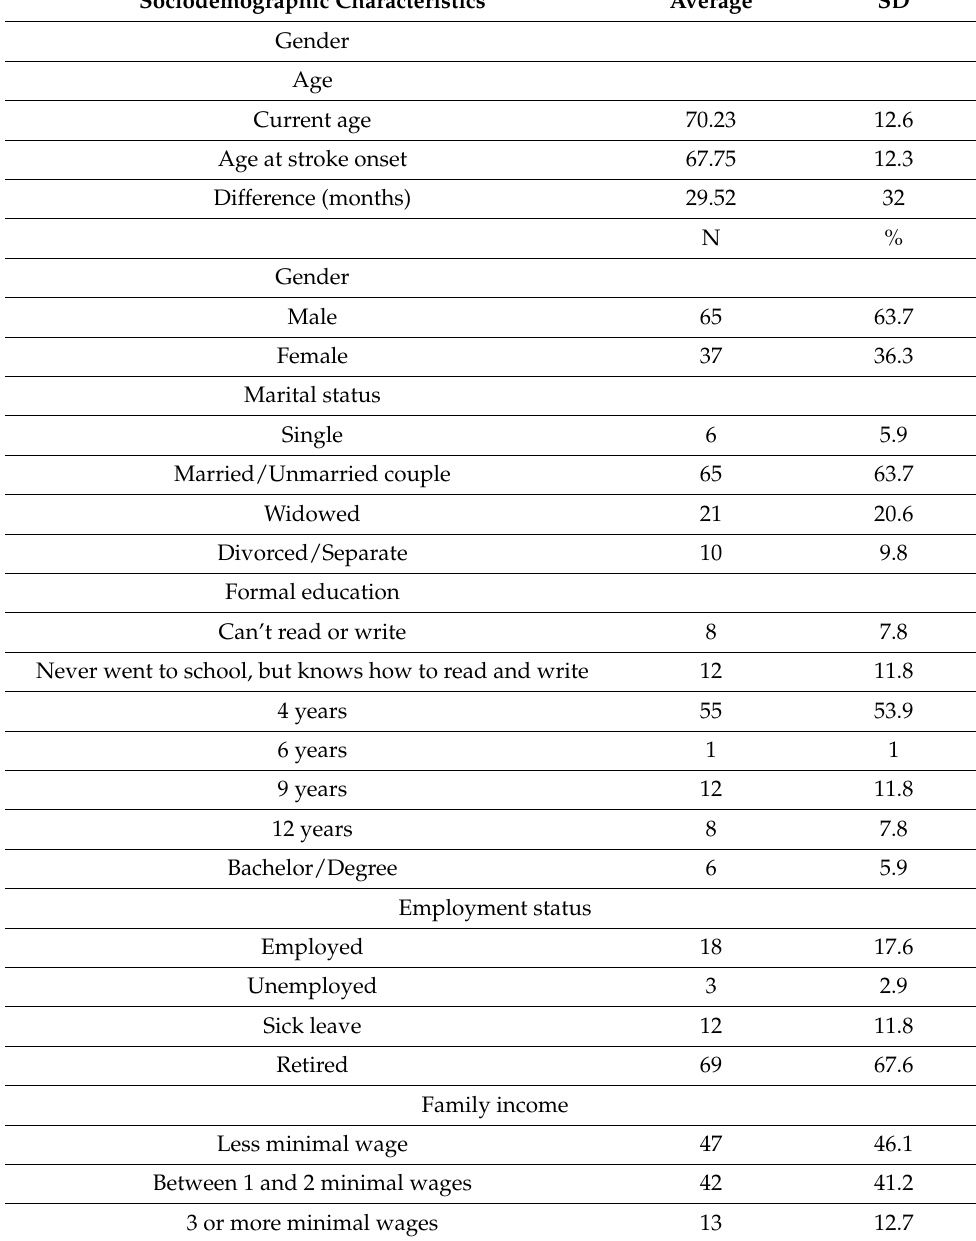
Table 1. Sociodemographic characteristics of the stroke survivors ( n =